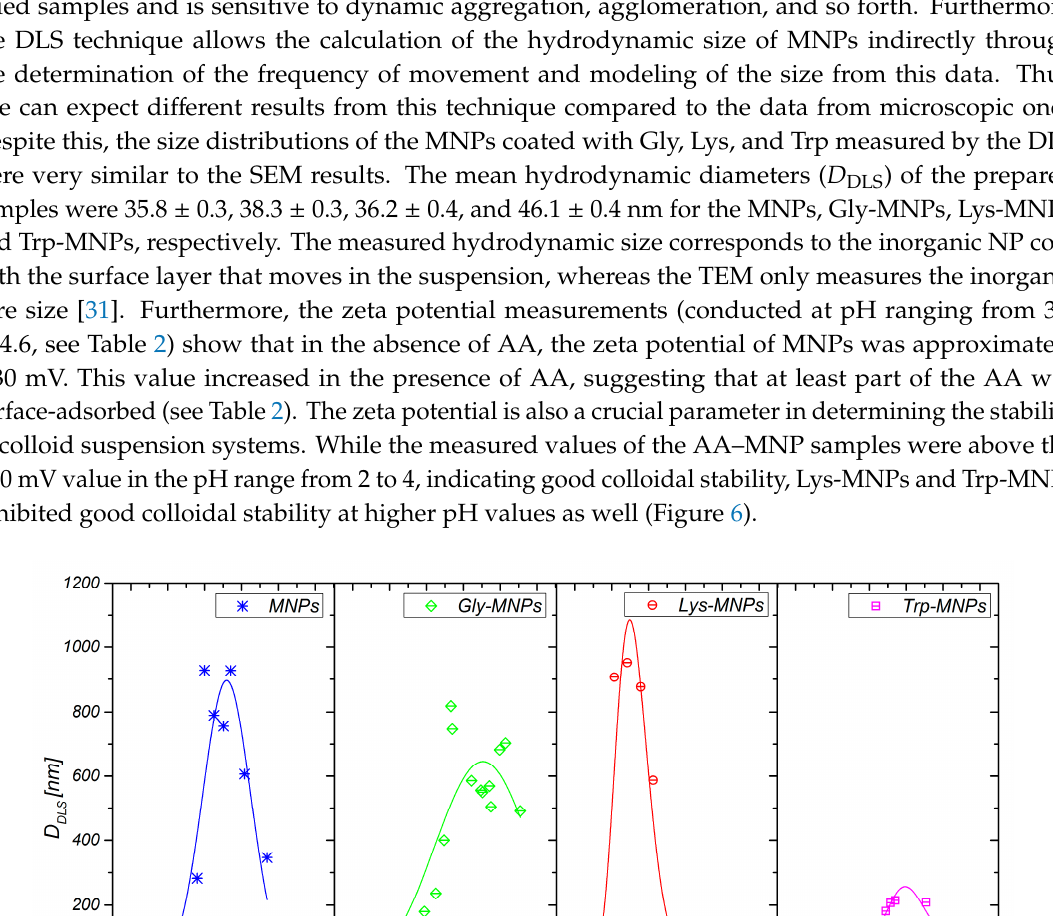
Figure 5. Scanning electronic microscope (SEM) images of MNPs, Gly-MNPs, Lys-MNPs, and Trp-MNPs.